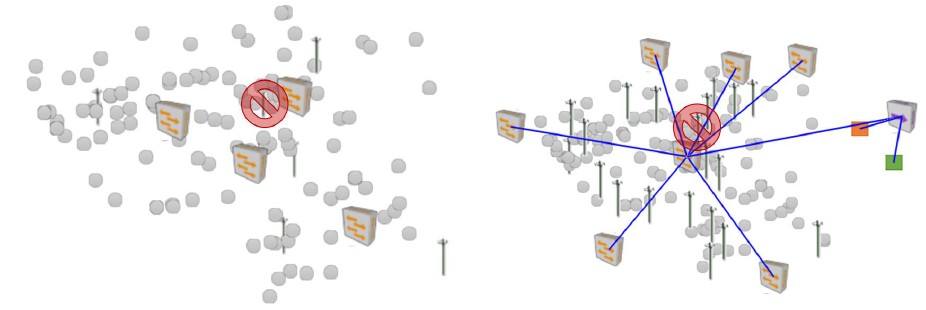
Figure 5. Base station failure in the modeled communication